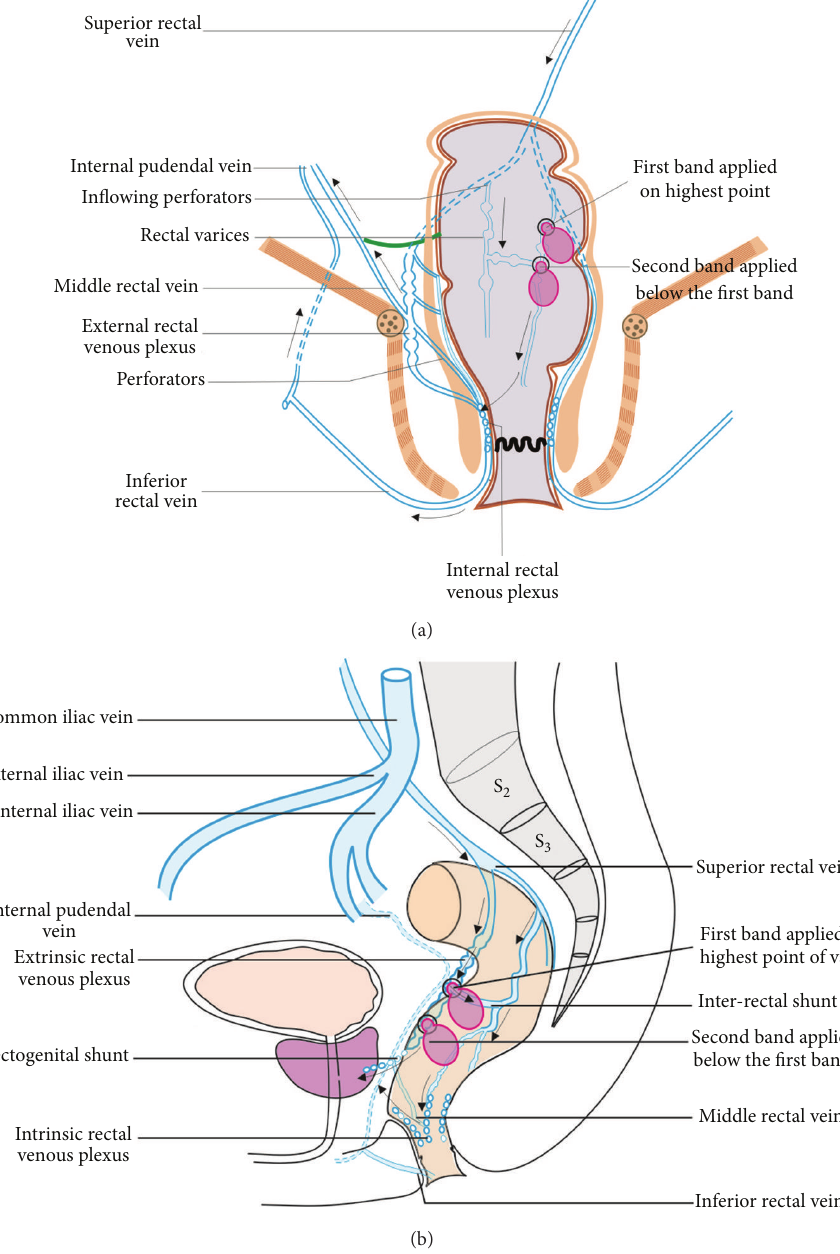
Figure 6: The direction of flow in rectal varices as shown in the figure is generally hepatofugal. The rectal varices are formed from these upper submucosal veins of intrinsic rectal venous plexus. From both the plexuses the portal hemorrhoidal blood works into systemic circulation through two portosystemic shunts (recto genital and inter rectal). The recto genital communication connect the rectal venous plexus with vesicoprostatic or vaginal venous plexus. The inter rectal communications occur between the three rectal veins. In rectal varices the banding should be done from above